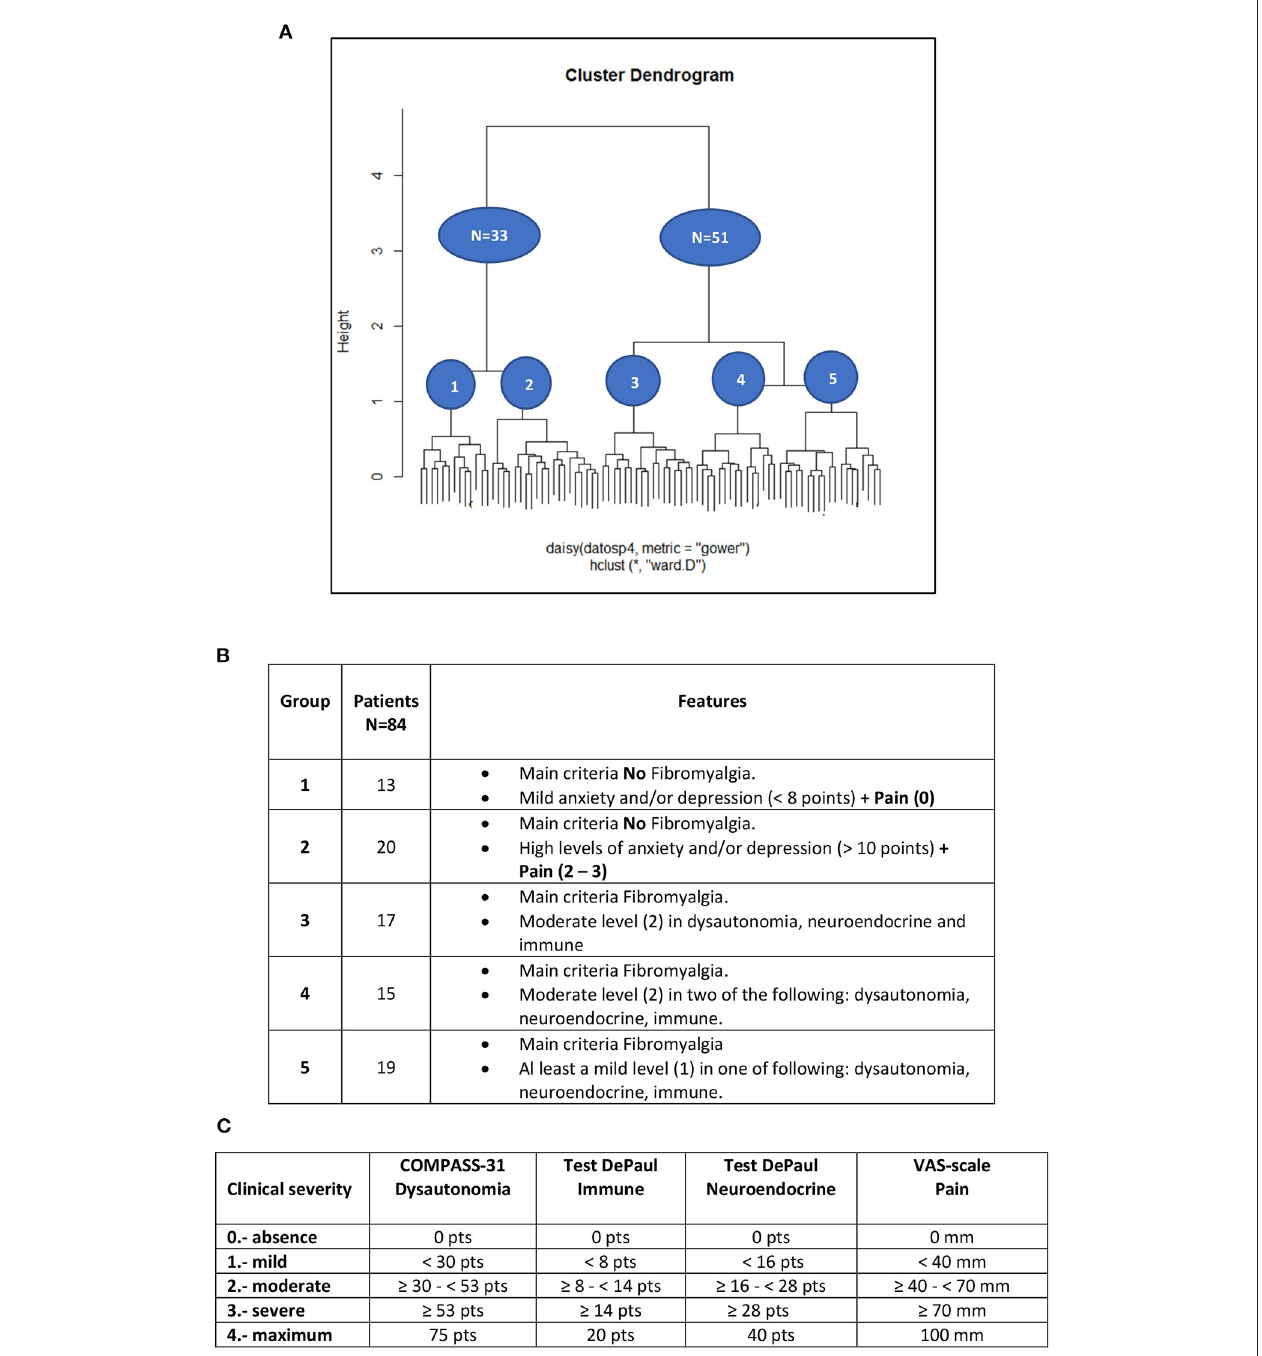
FIGURE 1 | (A) Dendrogram displaying cluster analysis of ME/CFS patients. (B) Table explaining the features of groups. The scores of Anxiety and Depression test (HAD) establish no repercussion ( < 8 points) up to 8 borderline (8–10 points) and repercussion ( > 10 points). (C) Table summarizing ranks of the scores for the more relevant tests in the clustering